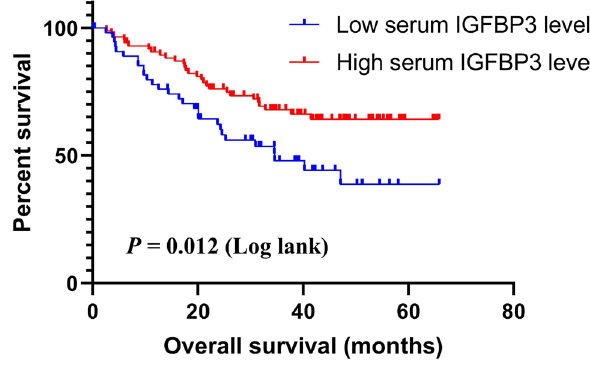
Fig. 3 Kaplan–Meier curves for serum IGFBP3 with EJA patients. Patients with low serum IGFBP3 level had short survival. EJA esophagogastric junction